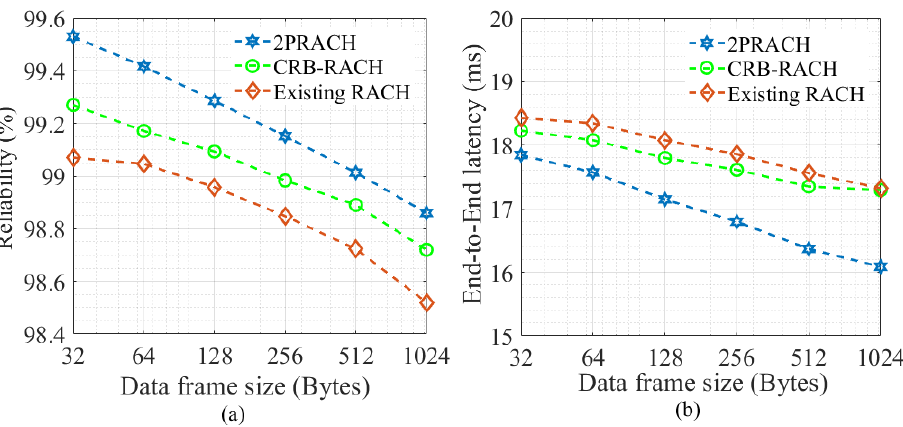
Figure 5. Performance comparison of 2PRACH with existing RACH and CRB-RACH procedures with varying data frame sizes, where ( a ) network reliability (%), and ( b ) end-to-end latency (ms).